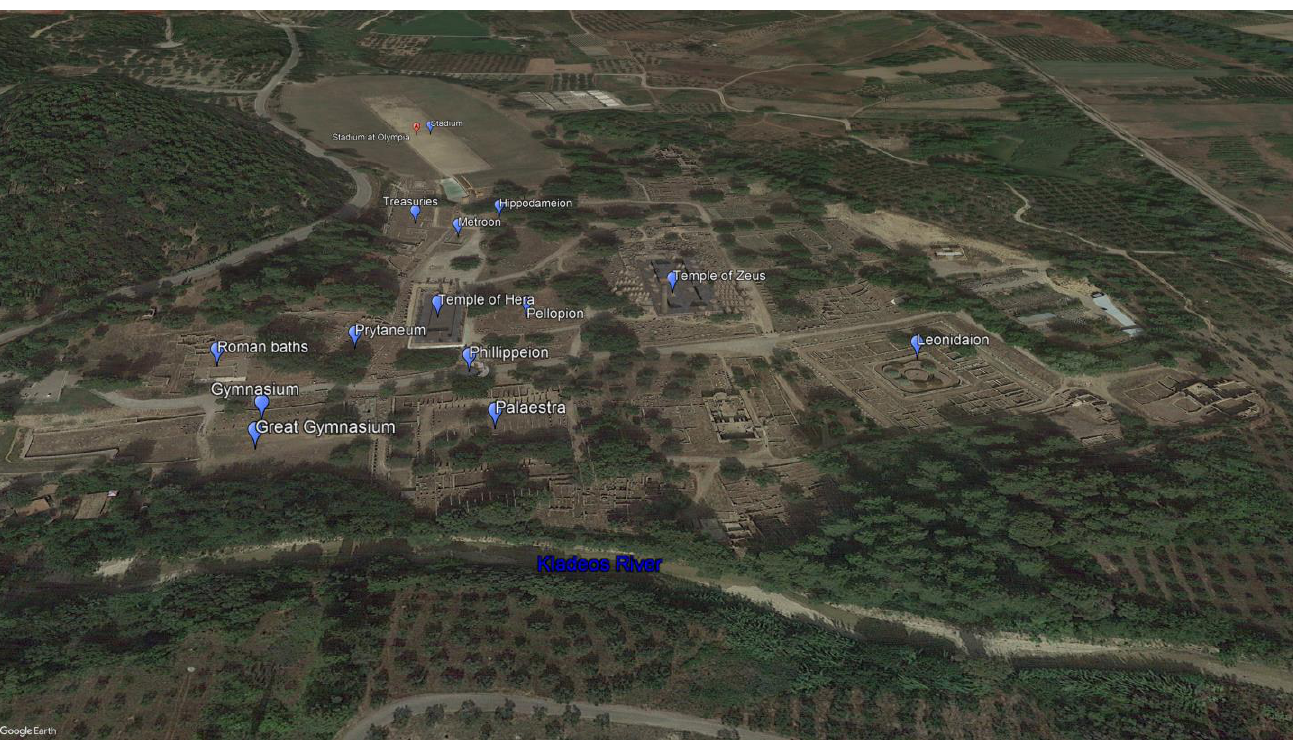
Figure 2. The archaeological site of ancient Olympia (Source: Google Earth).